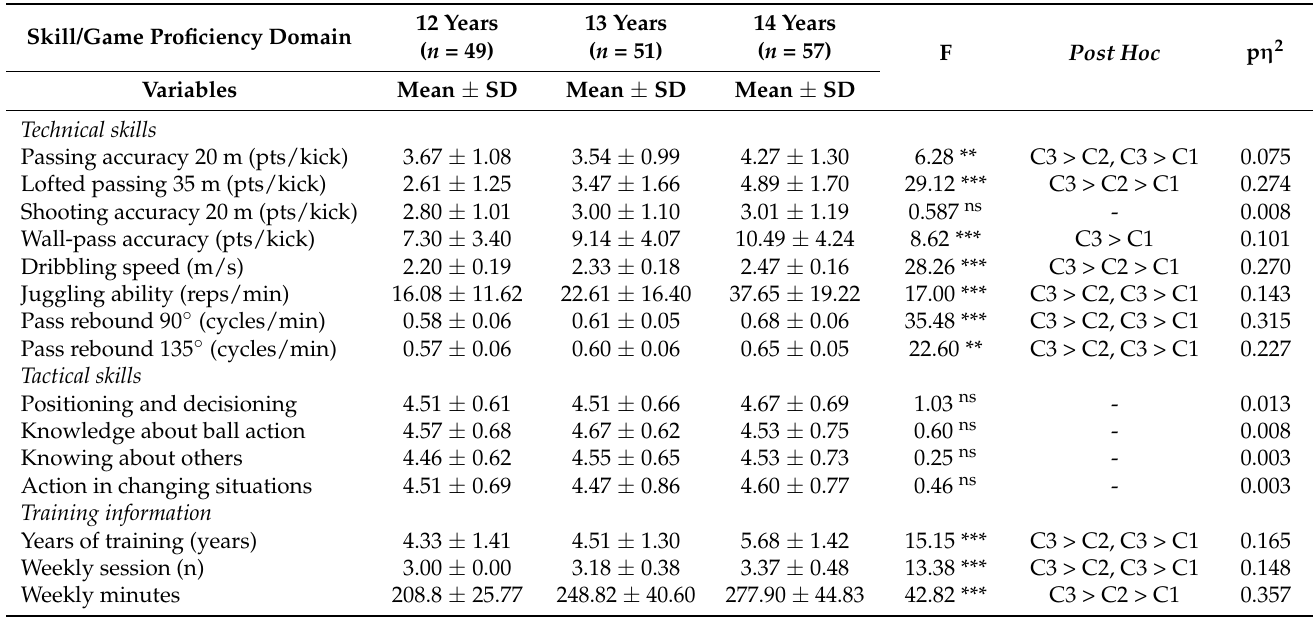
Table 4. Descriptive statistics [means and standard deviations (SD)], ANOVA results (F and post hoc tests), and partial eta square (p η 2 ) for the skill/game proficiency domain.